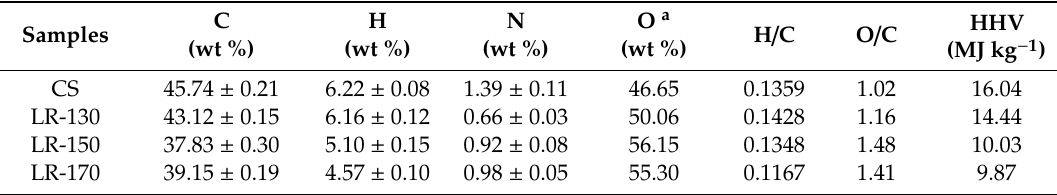
Table 2. Elemental analysis of CS and LRs.